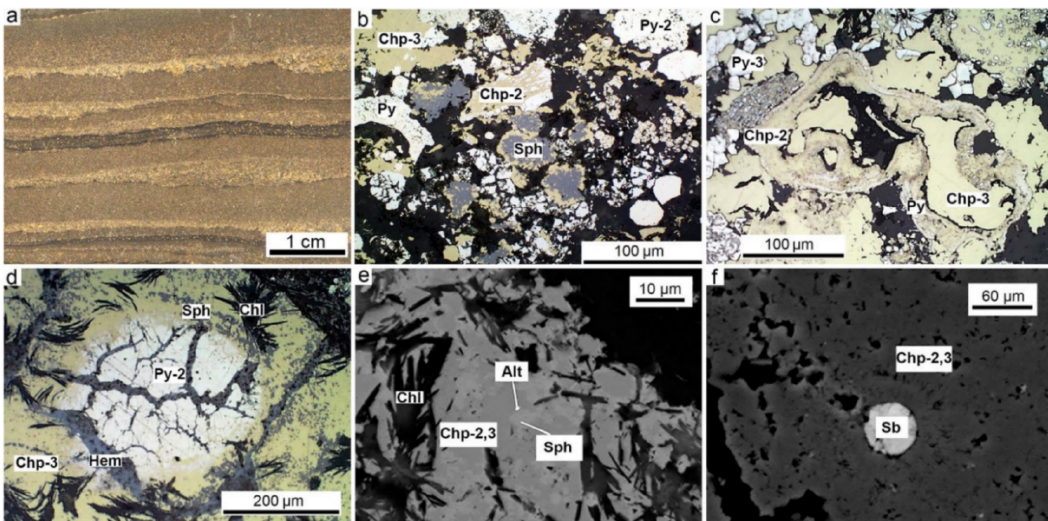
Figure 8. Mineralogical features of chalcopyrite-rich diagenites of the Yaman-Kasy deposit: ( a ) General view; ( b ) immature replacement of pyrite and sphalerite clasts by chalcopyrite-2; ( c ) mature replacement of pyrite clast and vestimentifera tube by chalcopyrite-2 and -3; ( d ) replacement of pyrite clast by chalcopyrite followed by hematite and chlorite; ( e ) inclusion of altaite in chalcopyrite-2,3 with relict sphalerite replaced by chlorite; ( f ) native antimony inclusion in chalcopyrite-2,3. ( a ) Polished sample, ( b – d ) reflected light, ( e , f ) back-scattered electron (BSE)